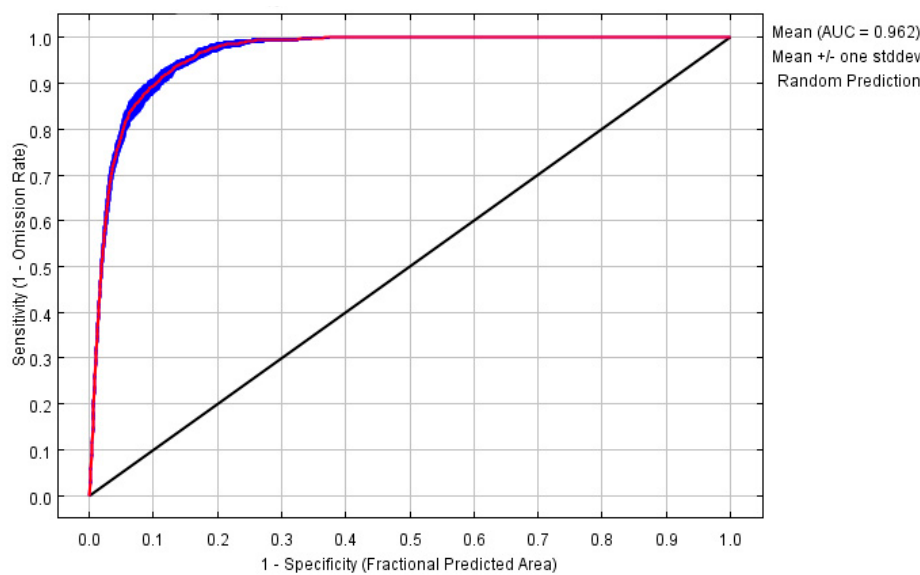
Figure 3. The receiver operating characteristic (ROC) curve and average area under curve (AUC) values for the optimized model over 10 replicate runs were shown in red, while blue margins show ± standard deviation (SD) calculated for 10 replicates.